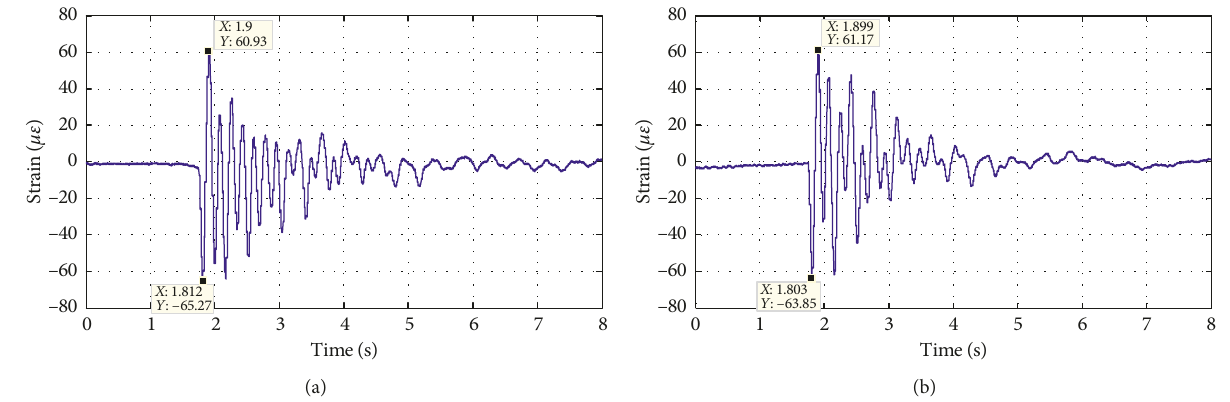
Figure 8: Stain measurement results of the on-orbit flying testing. (a) Sensor 1. (b) Sensor 2.